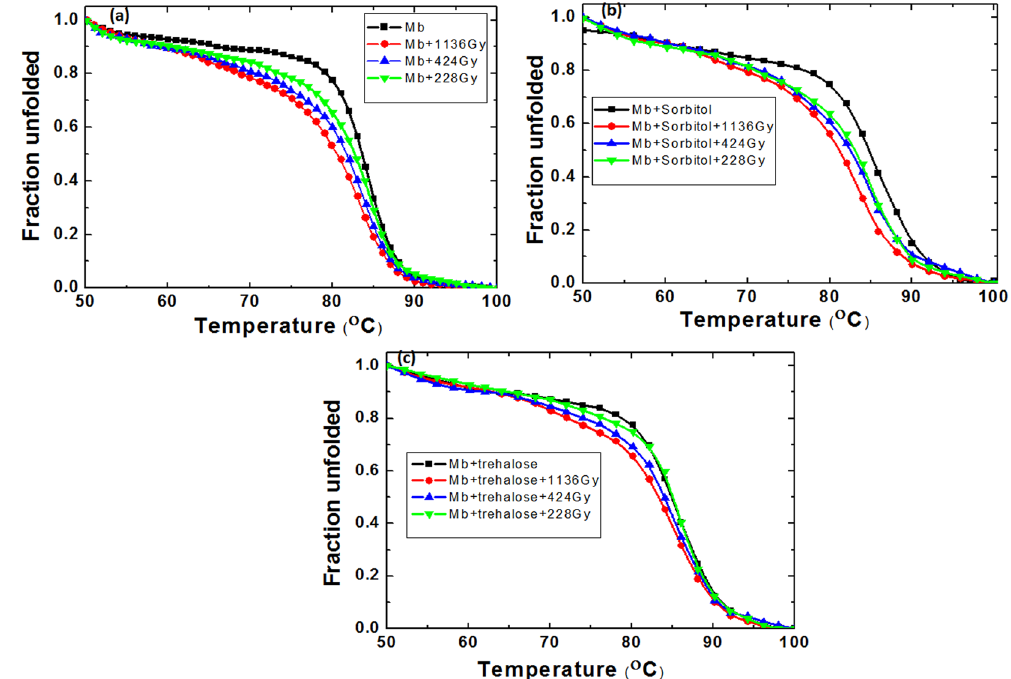
Figure 1. Thermal denaturation profile of Myoglobin protein after treatment with different gamma rays absorbed dose such as 1136, 424 and 228 Gy ( a ) control Myoglobin, ( b ) Myoglobin + sorbitol and ( c ) +